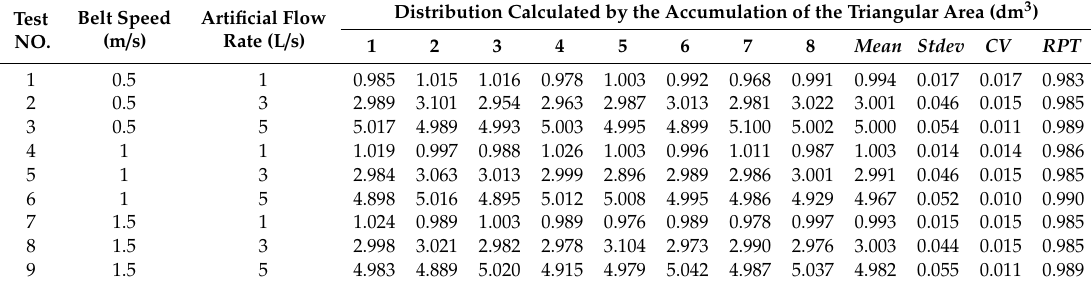
Table 2. Measured values of the iron ore powder distribution based on laser scanning and their